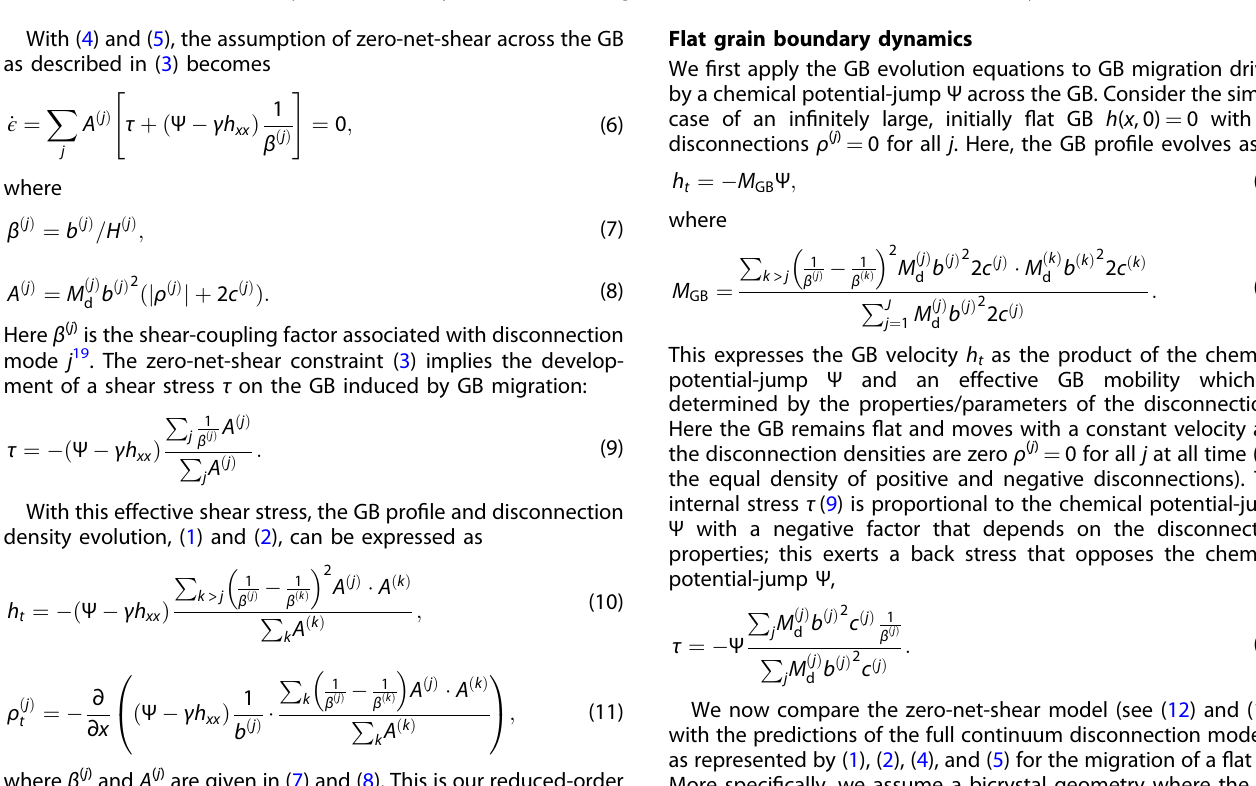
Fig. 2 Continuum representation of GB with disconnections. A GB with disconnections (black curve) and its continuum representation y = h ( x , t ) (red curve). The GB velocity v (in direction y ) results from the glide of disconnections in x , characterised by ( b , H ) and ( − b , − H